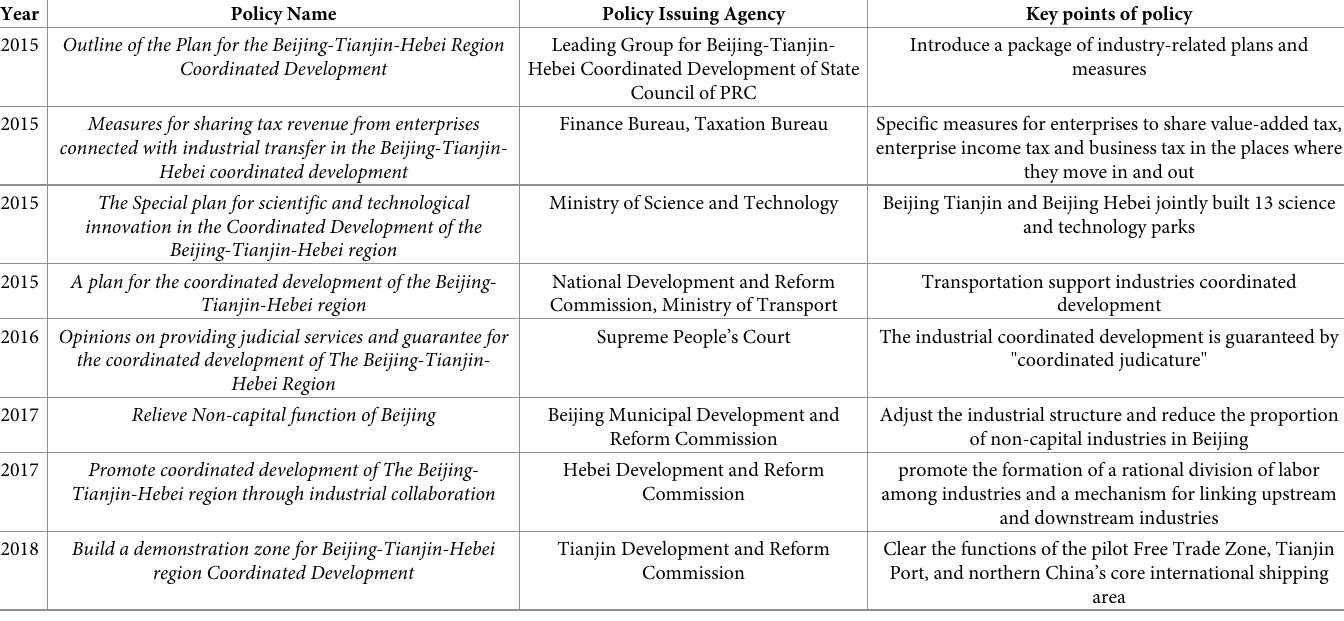
Table 1. List of representative policies Beijing-Tianjin-Hebei industrial